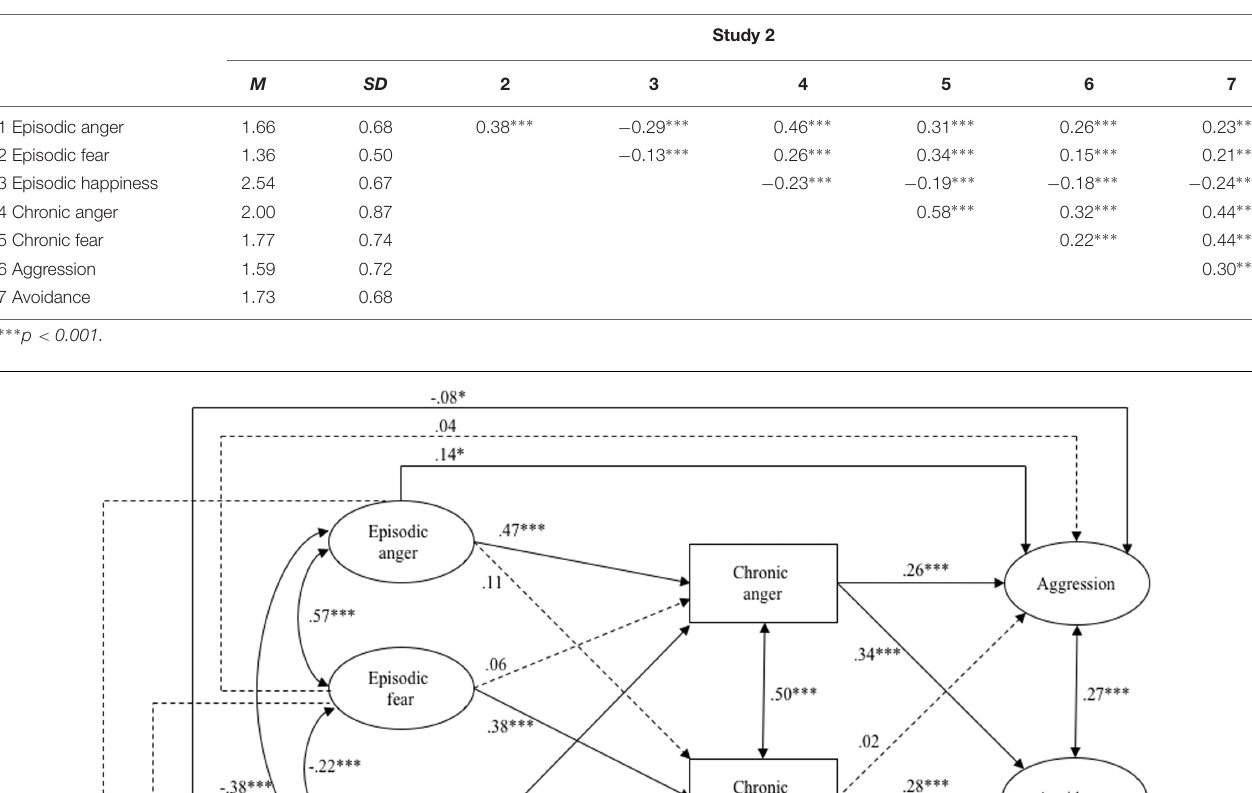
TABLE 2 | Means, standard deviations, and intercorrelations of measures for Study 2.